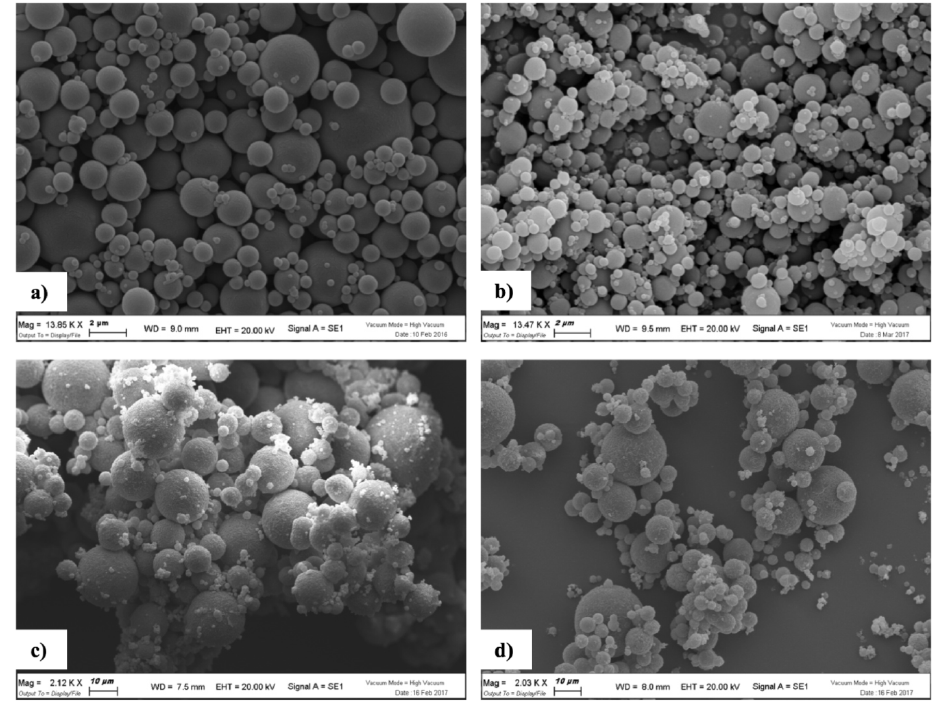
Figure 3. SEM micrographs of hyaluronan MS produced after 60 min of emulsification: HA ( a ), HA-SAP ( b ), HA-CL ( c ), HA-CL–SAP ( d ).